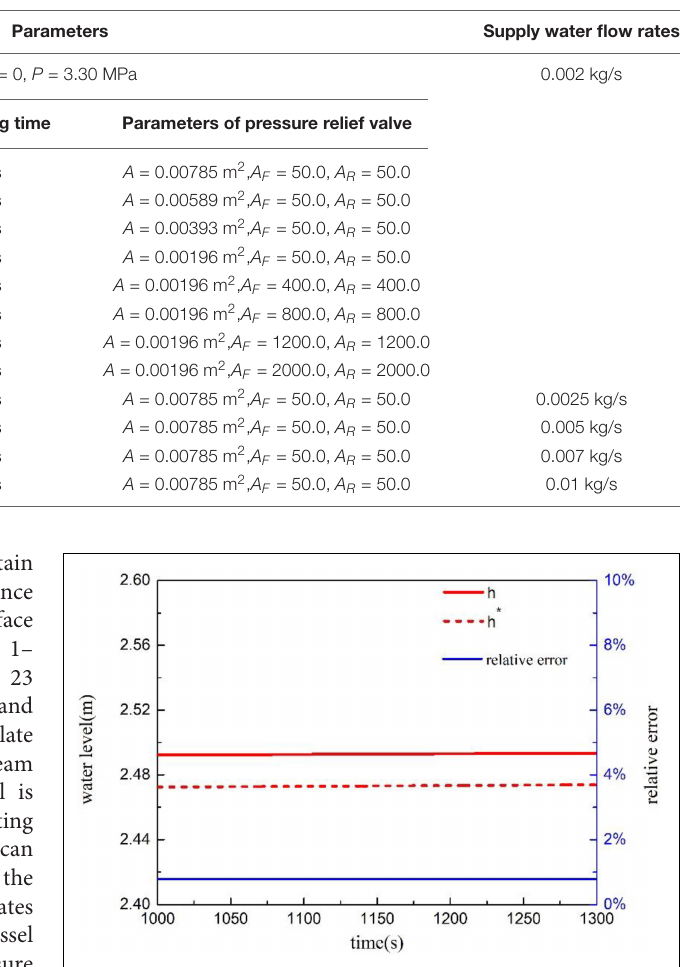
Transient condition No.